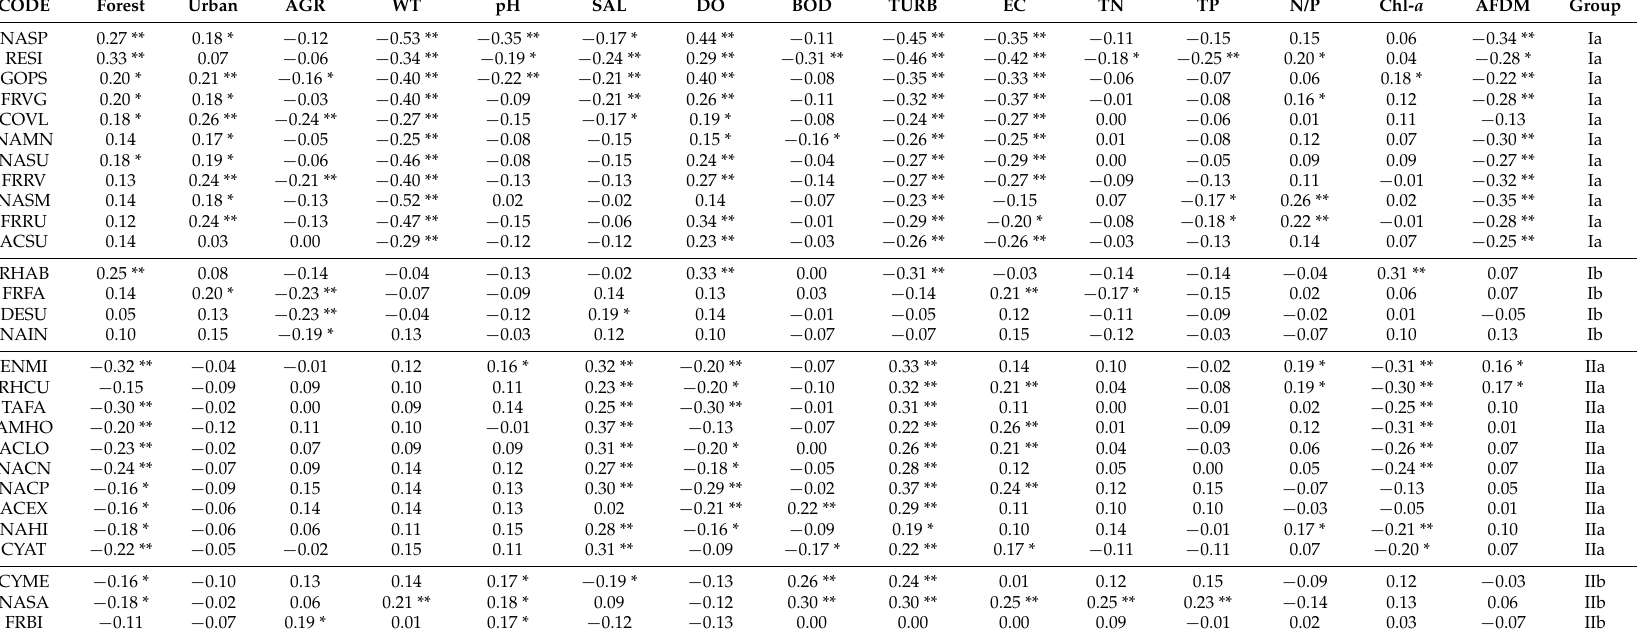
Table 3. Correlation coefficients among indicator species and environmental variables in each group of Korean estuaries between 2012 and